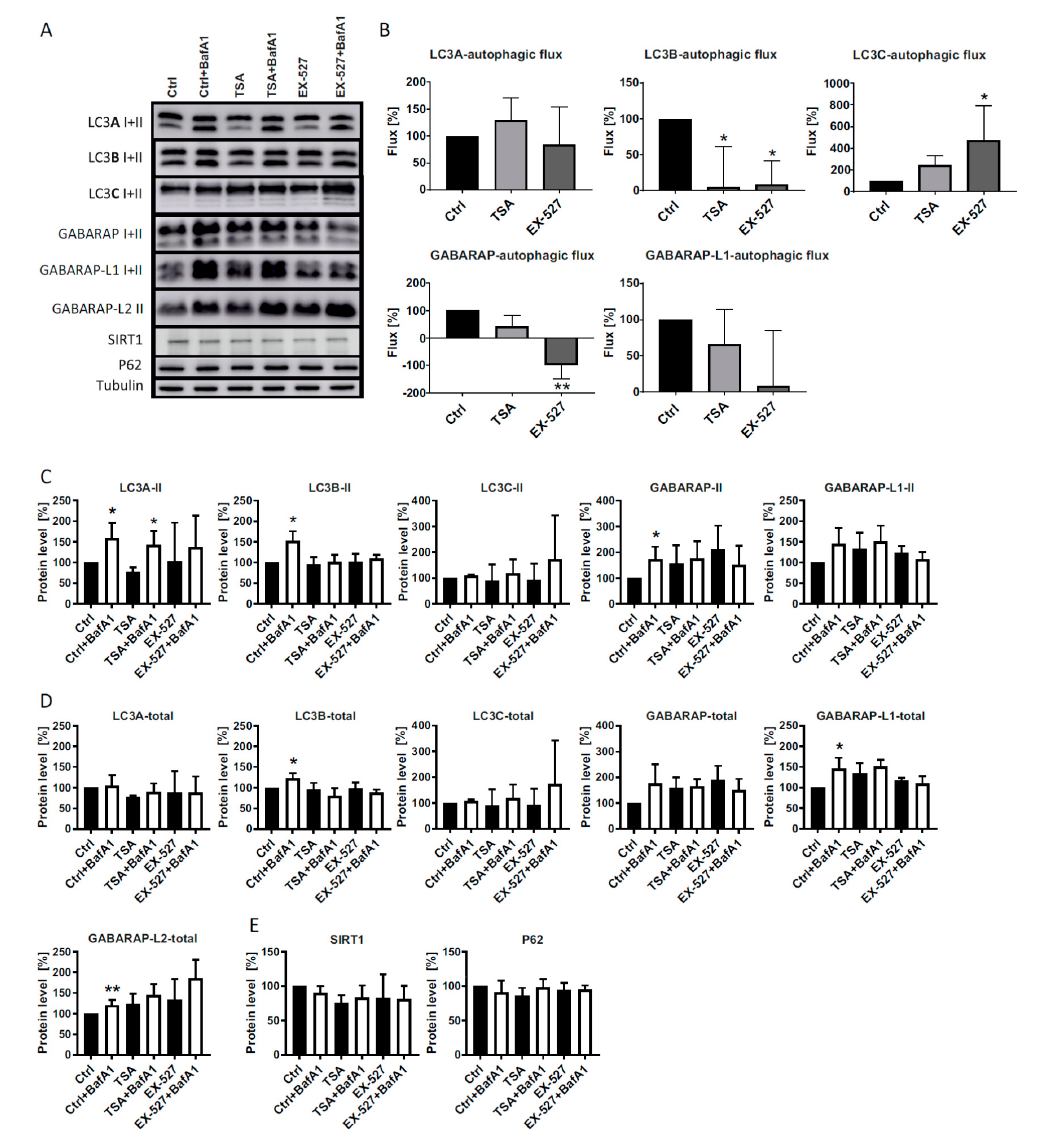
Figure 1. Analysis of LC3 family protein expression and lipidation. ( A ) Total cell lysates from primary human fibroblasts treated with BafA1, Ex527 or TSA for 48h were analyzed by Western blot as indicated. ( B – E ) Densitometric quantifications of the immunoreactive bands from n = 3 independent experiments. Raw numbers were first normalized to tubulin, and the resulting values were related to the similarly tubulin-normalized control (Ctrl). ( B ) Autophagic flux analyses in cells treated as indicated for 48h. Analysis was performed for each ATG8 protein by determining the difference, between BafA1-treated and BafA1-untreated cells, of the intensity of the lipidated bands running below the unlipidated bands [Flux = (LC3II / Tub) with BafA1 —(LC3II / Tub) without BafA1 ]. Significant changes (by one-way ANOVA on ranks) versus the control: * p ≤ 0.05; ** p ≤ 0.01. ( C ) Raw intensities of all lipidated protein bands (tubulin-normalized). Significant changes (by two-way ANOVA) versus BafA1-untreated cells: * p ≤ 0.05; ** p ≤ 0.01. ( D ) Raw intensities of all lipidated and unlipidated protein bands (tubulin-normalized). Statistical analysis was done as in ( C ). ( E ) Quantification of SIRT1 and p62 expression (tubulin-normalized).